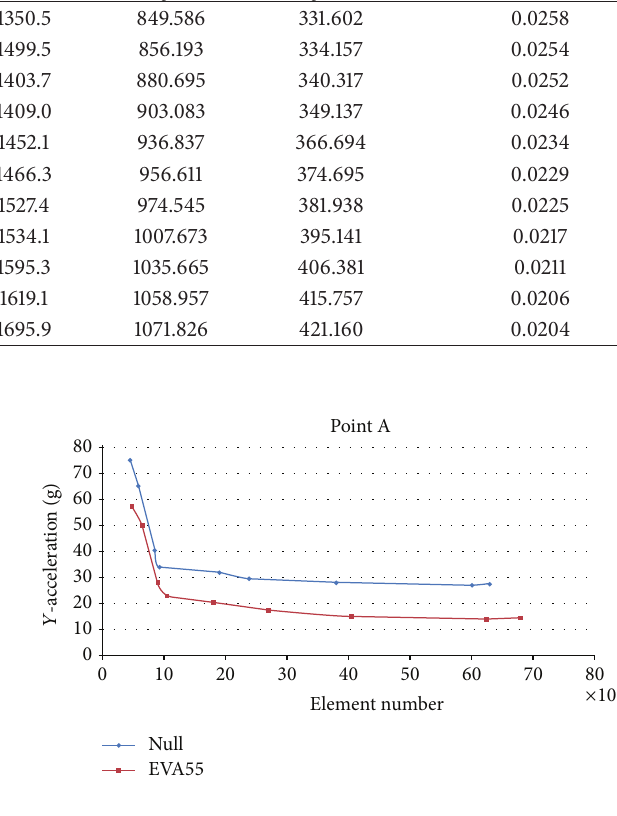
Figure 7: Convergence analysis for element number without and with resilient materials.